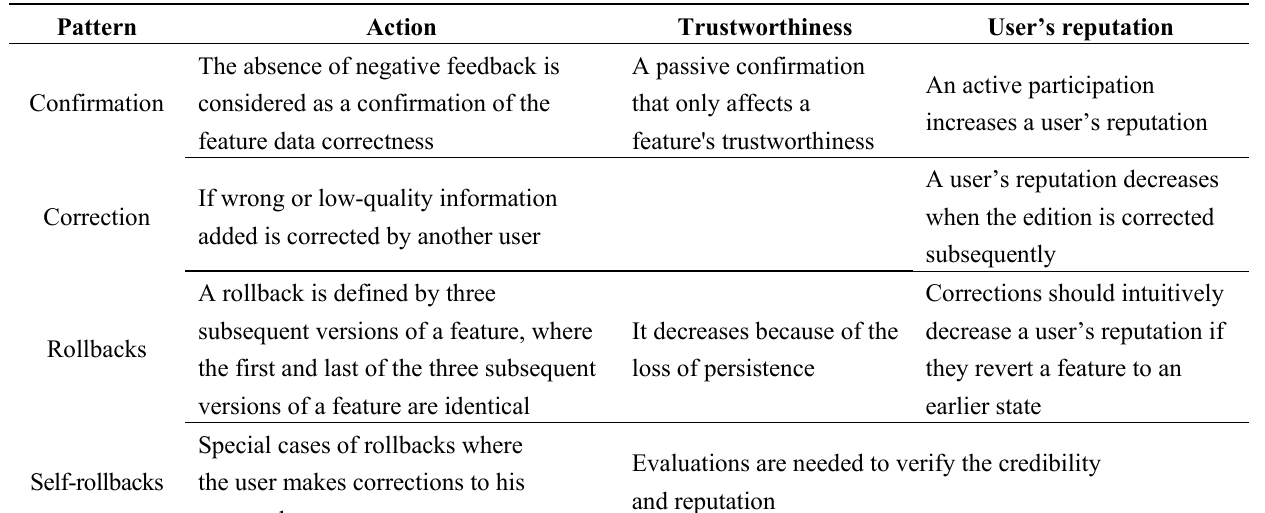
Table 5. Patterns as subclasses of the Edit class (Source: